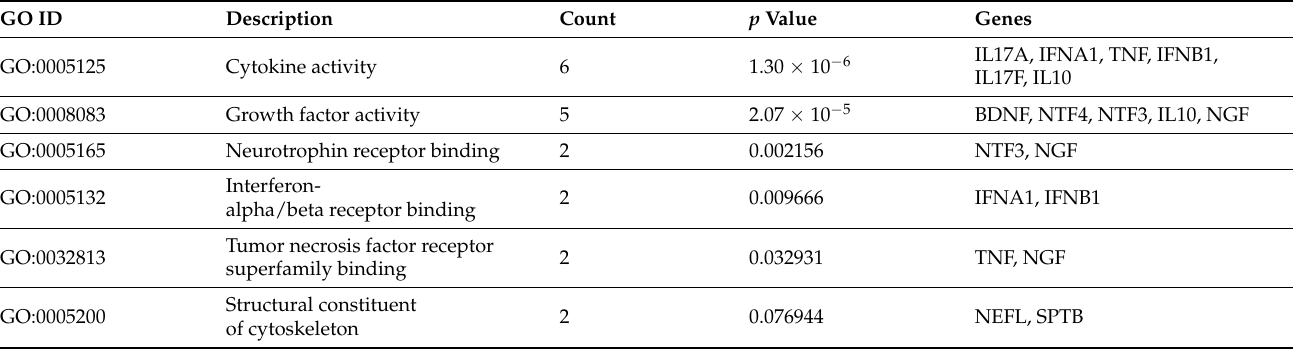
Table 2. GO analysis molecular function (MF) of genes associated with cognitive dysfunction in MS.